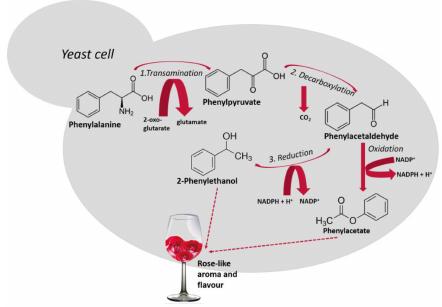
Figure 1. Schematic representation of the Ehrlich pathway for the catabolism of the aromatic amino acid, phenylalanine leading to the formation of 2-phenylethanol [34]. This biosynthetic pathway consists of three steps (reactions 1, 2 and 3): first, amino acids are deaminated to the corresponding α -ketoacids, in reactions catalyzed by transaminases. In a second step, α -ketoacids are decarboxylated and converted to their corresponding aldehydes (five decarboxylases are involved in this process), in a third step, alcohol dehydrogenases (Adh1p to Adh6p and Sfa1p) catalyze the reduction of aldehydes to their corresponding higher alcohols